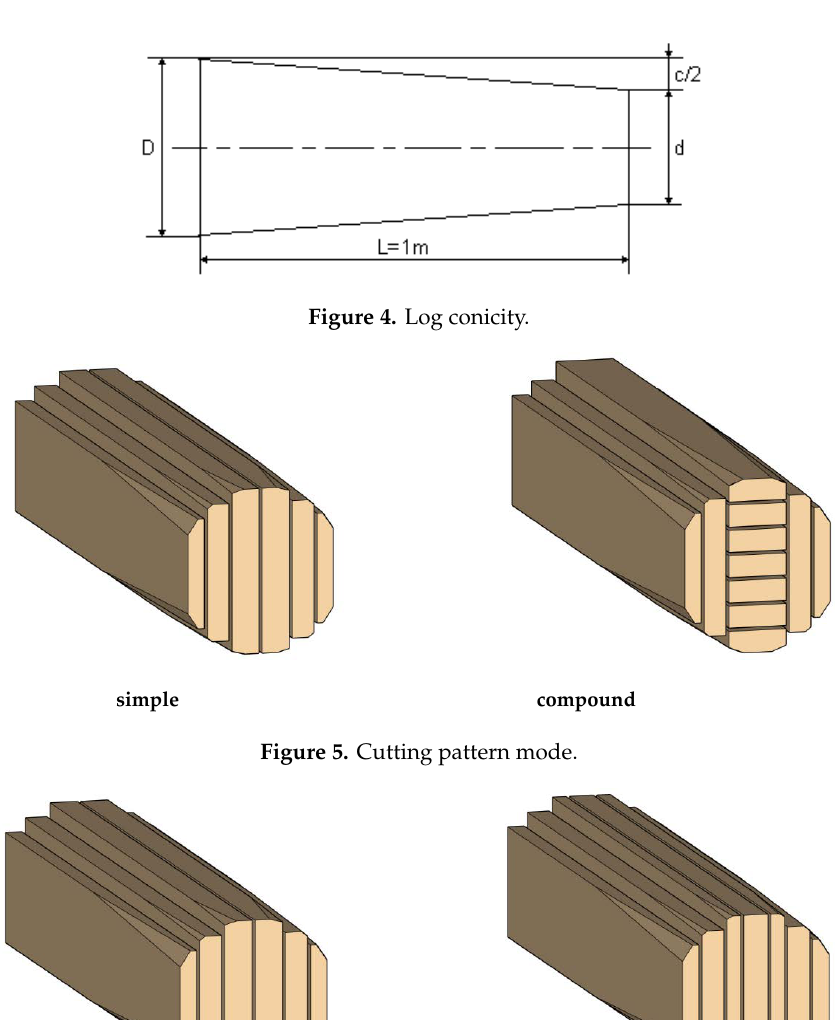
Figure 5. Cutting pattern mode.